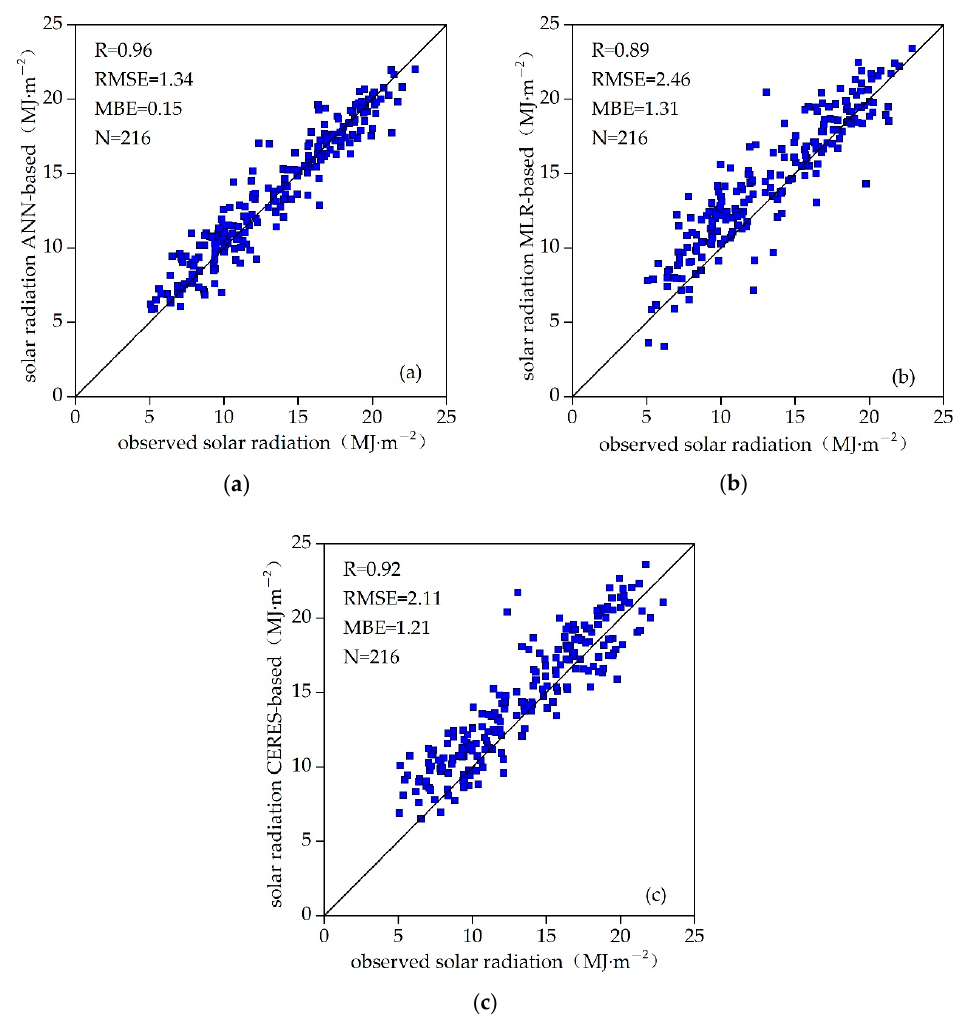
Figure 5. Comparison between observed solar radiation and simulated values after training at the training stations. ( a ), ( b ), and ( c ) are scatter plots of observed solar radiation and simulated solar radiation based on ANN method, MLR model and CERES products, respectively.